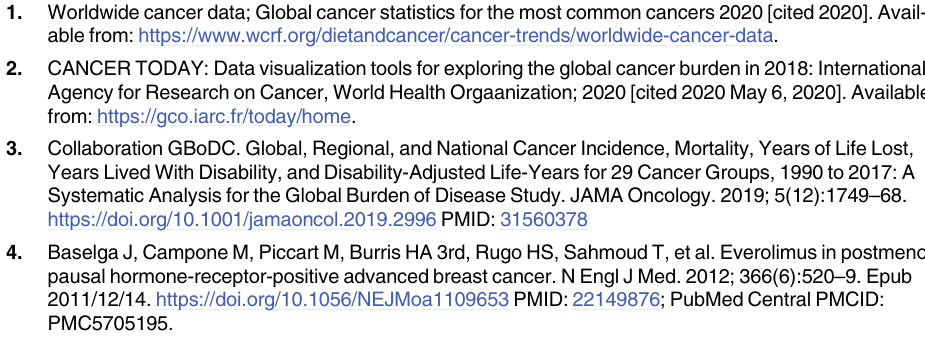
S4 Fig. Quantitation of 5-fluorouracil metabolites in wild-type and tamoxifen-resistant MCF7 cells. The intracellular concentrations of 5-fluorouracil metabolites, fluorodeoxyuridine (FdUrd, left panel ) and 2-fluoro- β -alanine (FBAL, right panel ) were quantitated by matrix- assisted laser desorption/ionization time-of-flight mass spectrometry (MALDI-TOF MS) as described in the S1 File . The amount of 5-fluorouracil active metabolite, FdUrd and FBAL were higher and lower in MCF7-T cells compared with those in wt-MCF7 cells, respectively. The experiment was done in